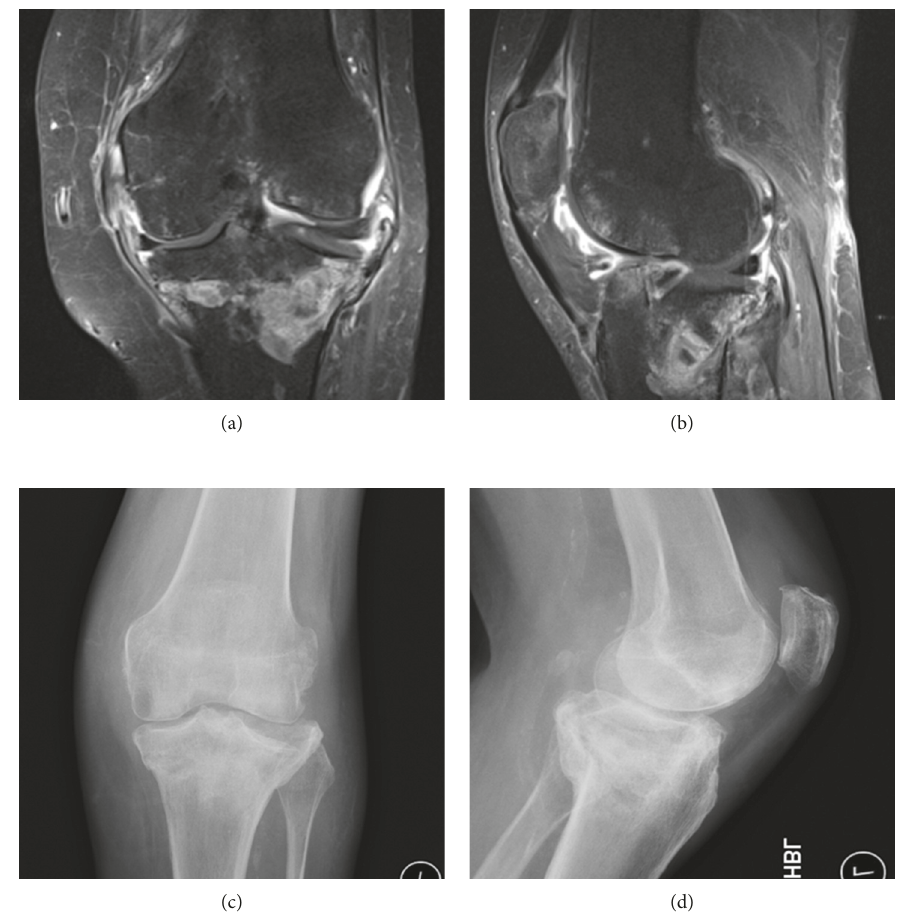
Figure 8: Post-Exogen therapy. (a) Coronal MRI T1 Fat Sat+Gad, (b) sagittal MRI coronal Fat Sat, (c) AP, and (d) lateral